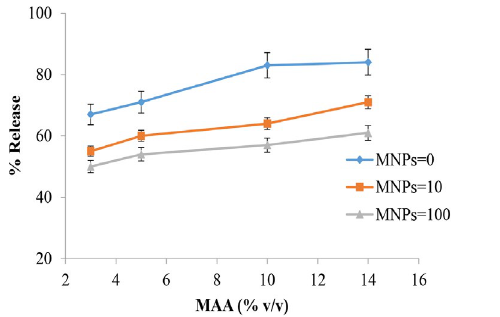
Fig. 7. Effect of MAA amount on the release of